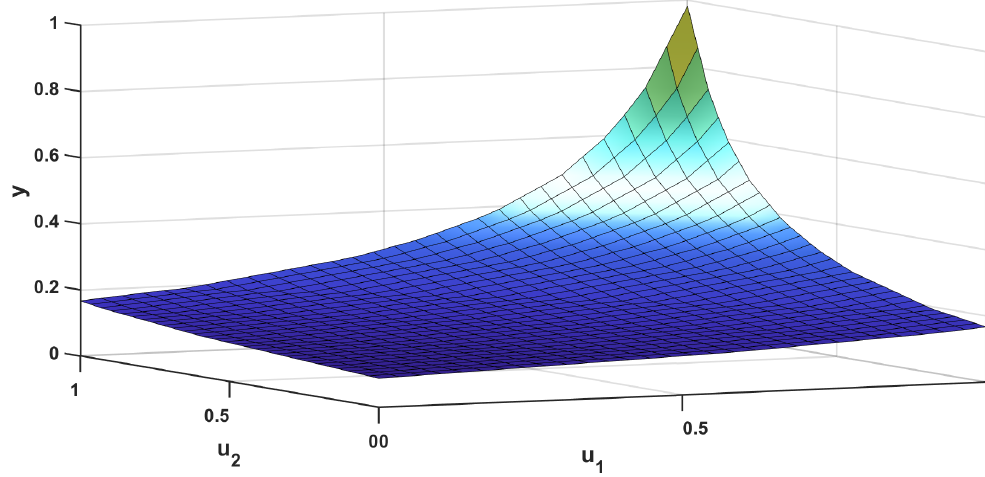
Figure 4. Function in Equation (8).